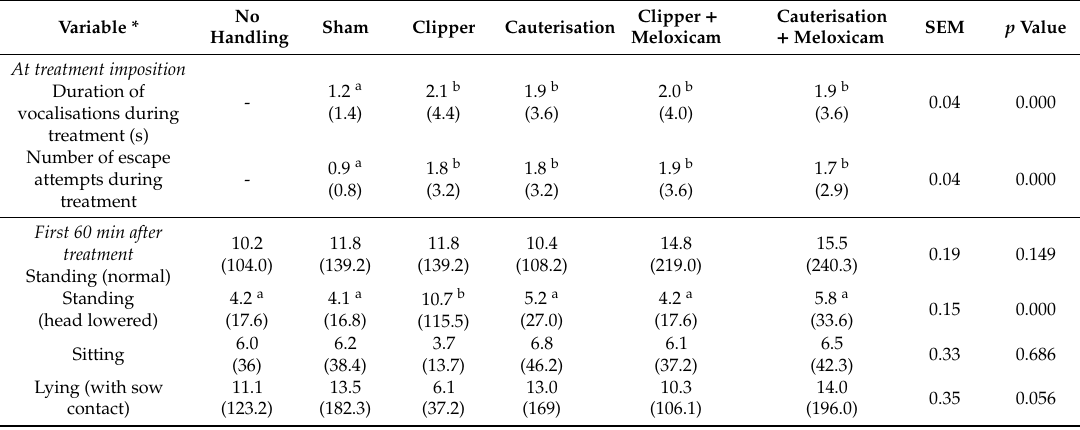
Table 3. E ff ect of treatment on the duration of vocalisations and number of escape attempts during imposition of treatments and duration of behaviours of piglets for the first 60 min after